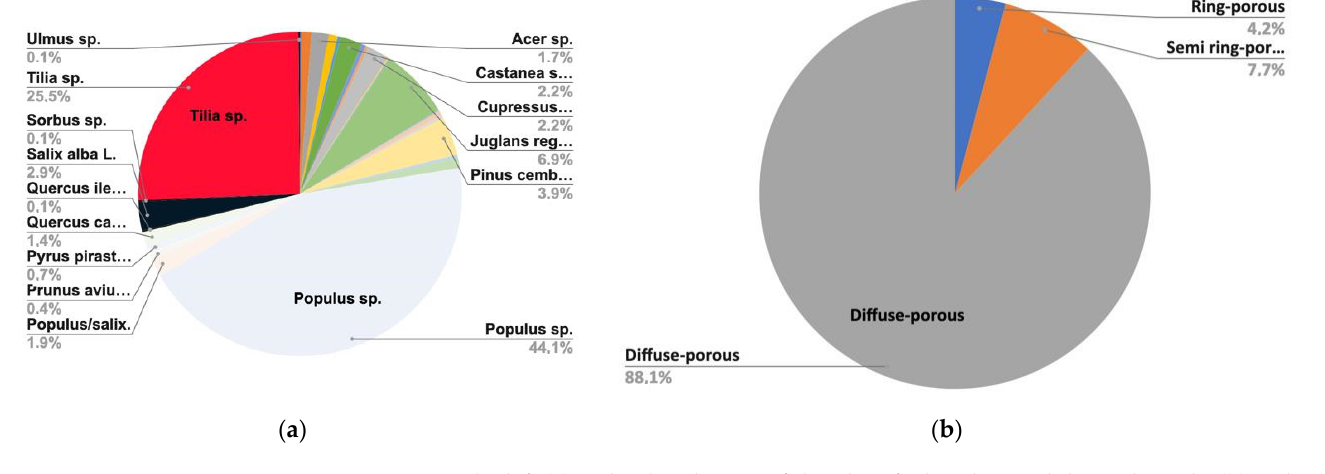
( c ) Figure 4. On the left is a type of wood with diffuse porosity (poplar), in the centre is a type of wood with semi-diffuse porosity (walnut), and on the right is a porous-ring type of wood (chestnut). The technical, material artist ’ s choice of wood would, therefore, seem to be closely suggested by wood anatomical features. Wood must preferably be a diffuse-porous hard- wood, and the identified timbers largely correspond to those listed by the Renaissance masters. In the case of softwood, only timbers with very thin layers of latewood were considered. 3.2. Geographic Distribution As suggested in the previous section, the anatomical features are key to understand- ing timber choices by artists, but can a correlation with the geographic distribution of the wood-producing trees be excluded? The recorded artefacts are from all European countries but with a very large majority from Italy, which are distributed between northern (227 identifications), central (262), and southern Italy (94). However, artworks produced by artists from German (54) and Alpine